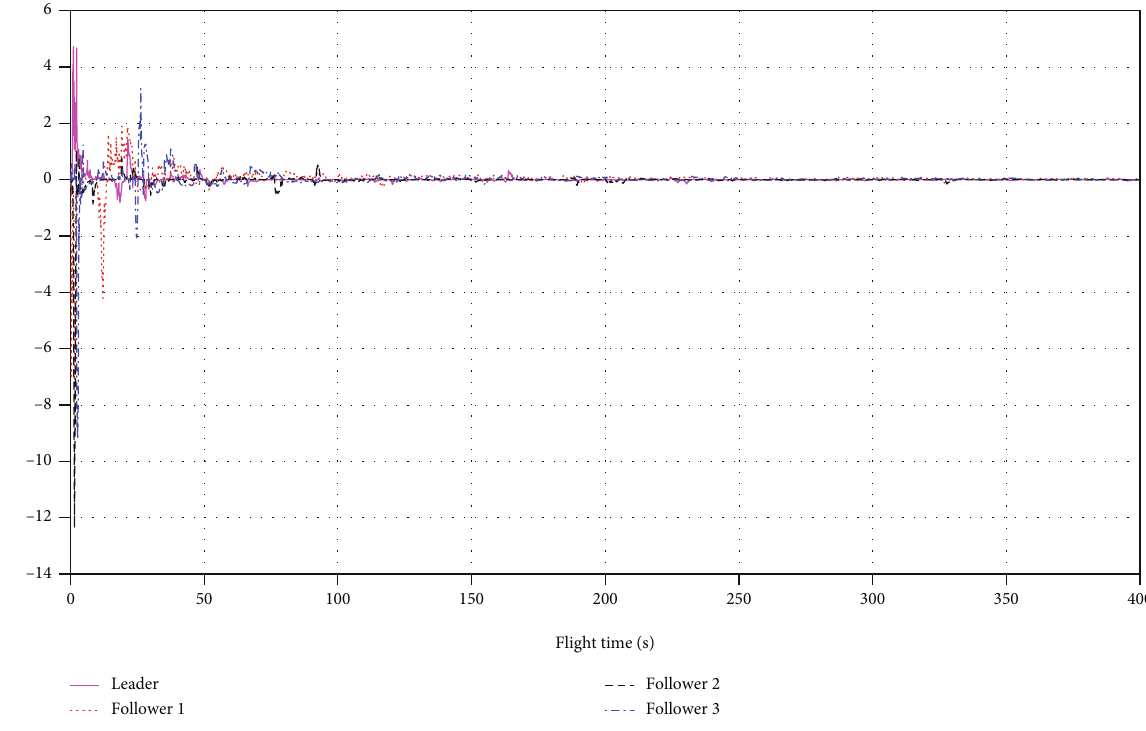
Figure 18: The control inputs for the UAV formation (with